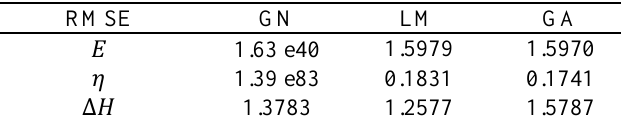
Table 1. Quantitative comparisons of accuracy for three algorithms in